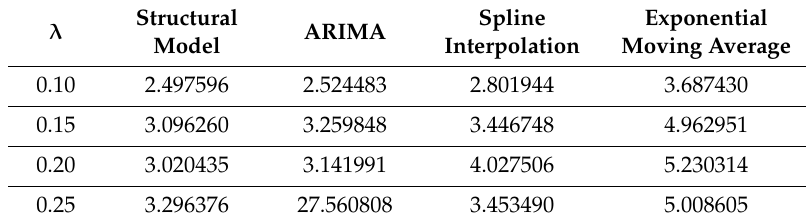
Table 2. Root mean square error (RMSE) for data imputation (lowest RMSE highlighted).